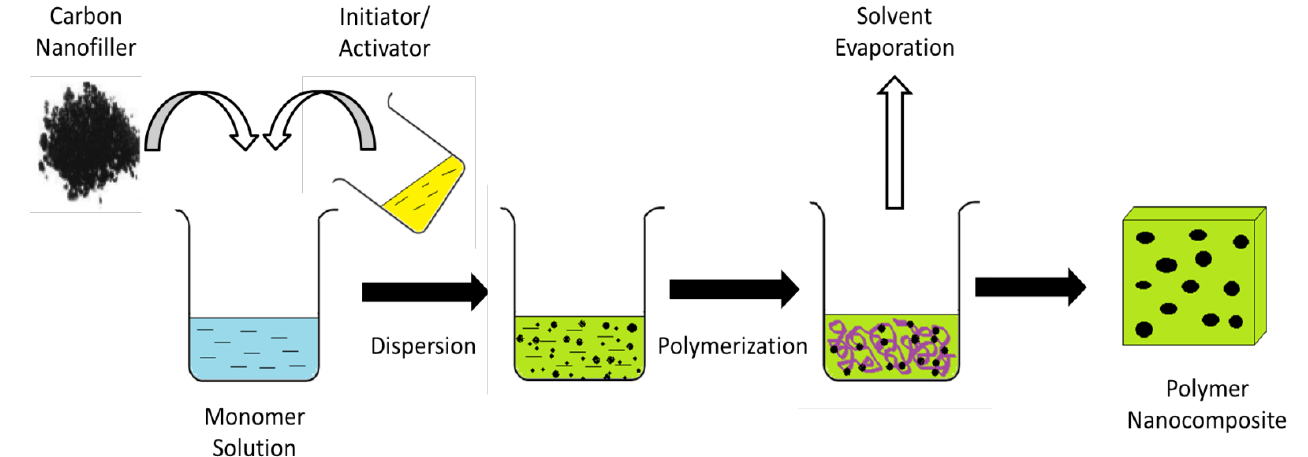
Figure 7. Process of in situ polymerization.